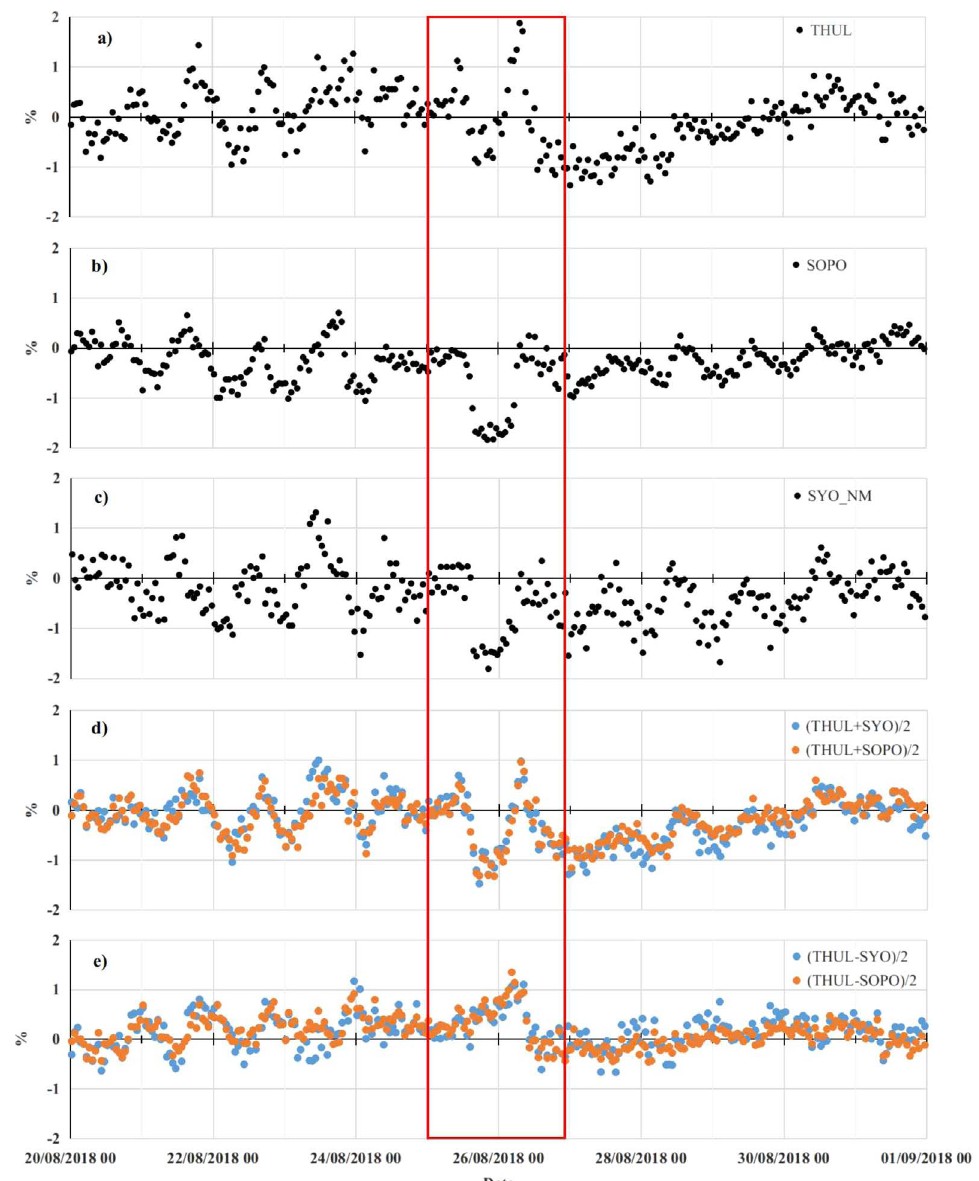
Fig. 14. Hourly count rate variations observed by (a) Thule NM (THUL), (b) South Pole NM (SOPO), and (c) Syowa NM (SYO NM). NM at northern and southern high-latitudes show different variations. To see contributions from the GCR density and the north – south anisotropy separately, we plot the average and difference between NMs at northern and southern high-latitudes in panels (d) and (e). Orange and blue solid circles in panels (d) and (e) show the average and difference in THUL and SOPO pair and THUL and SYO NM pair, respectively. Tick marks on the horizontal axis are at one day